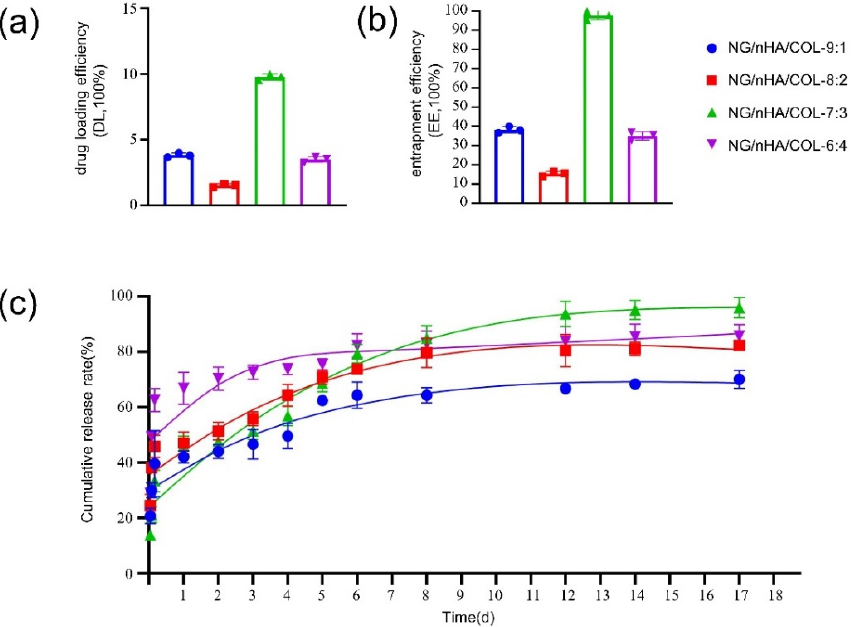
Figure 2. Drug loading efficiency, entrapment efficiency, and cumulative release rate of NG/nHA/COL: ( a ) drug loading efficiency (DL, 100%) of NG/nHA/COL, ( b ) entrapment efficiency (EE, 100%) of NG/nHA/COL, and ( c ) cumulative release rate (%) of naringin released from NG/nHA/COL.